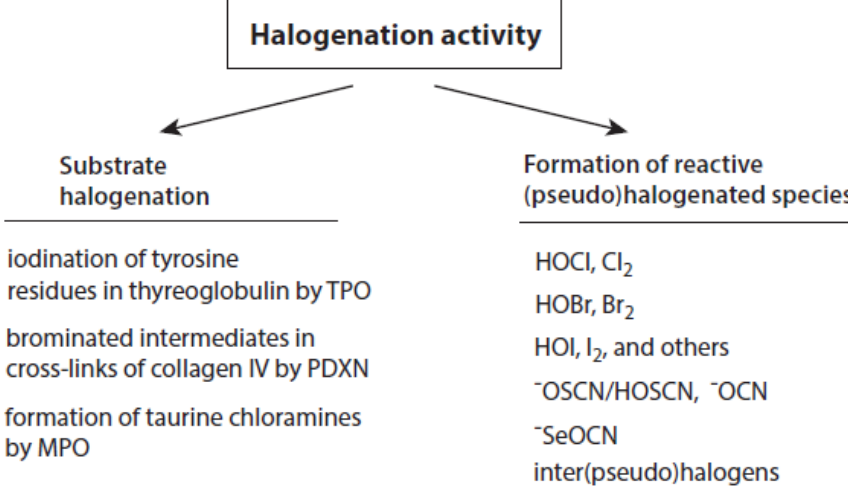
Figure 2. Overview about the halogenation activity of heme peroxidases. Explanations are given in the text.